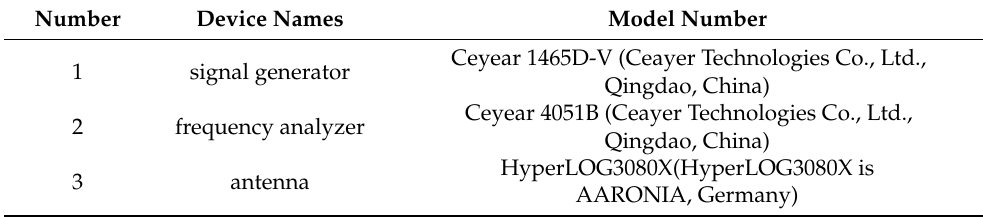
Figure 3. Configuration for signal collection system. (In the paper, we use Table 2 to explain for the number 1–3. ”1“ is signal genertor Ceyear 1465D-V; 2 is frequency analyzer Ceyear 4051B; “3” is antennas HyperLOG3080X. It consisted of one signal generator, one frequency analyzer, and two antennas with details given in Table 2”). Table 2. Devices used in signal collection system.